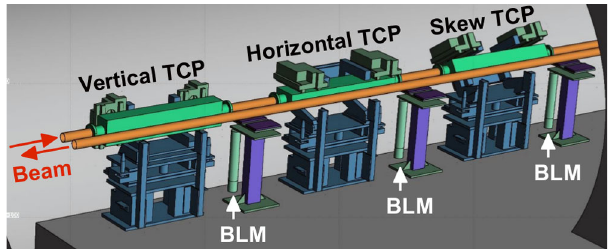
FIG. 14. The 3D geometry surrounding the three IR7 TCPs, as implemented in FLUKA. The collimator jaws are contained in the green metal tanks and the BLMs are the upright cylinders below each